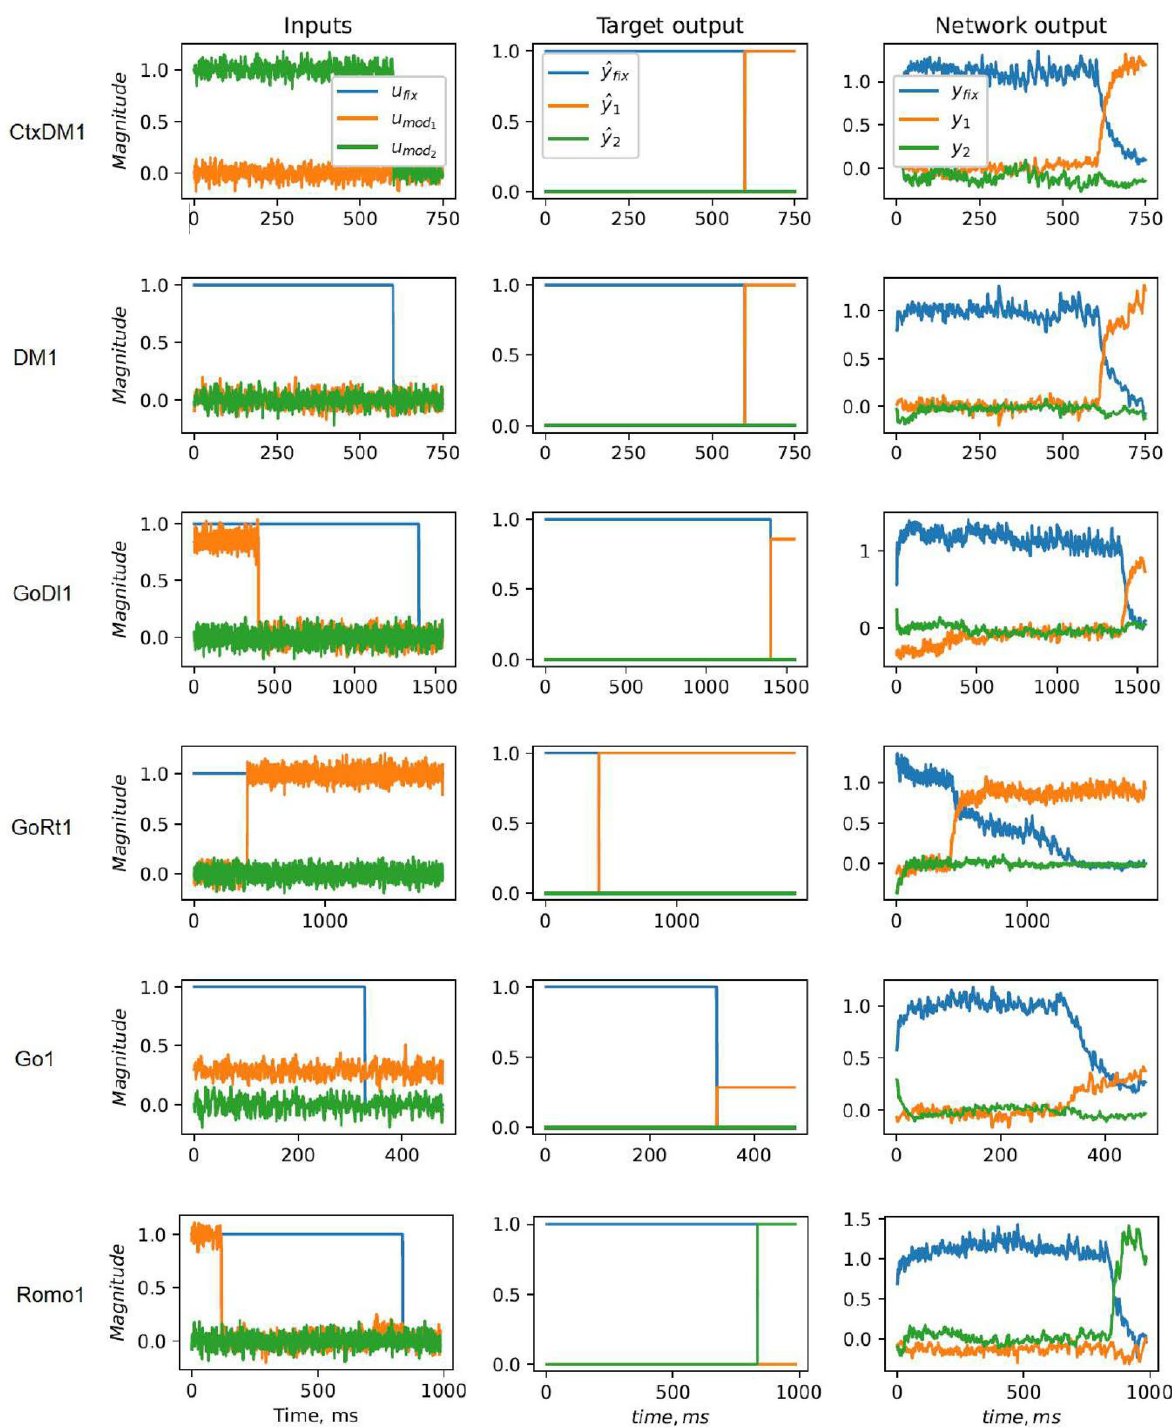
Figure 5. How the trained neural network performs different target tasks: the inputs (the first column) for the indicated tasks, the targets (the second column) and network output responses (the third column). The network with N = 256 neurons is trained with the mean-squared loss function, and the other parameters are taken